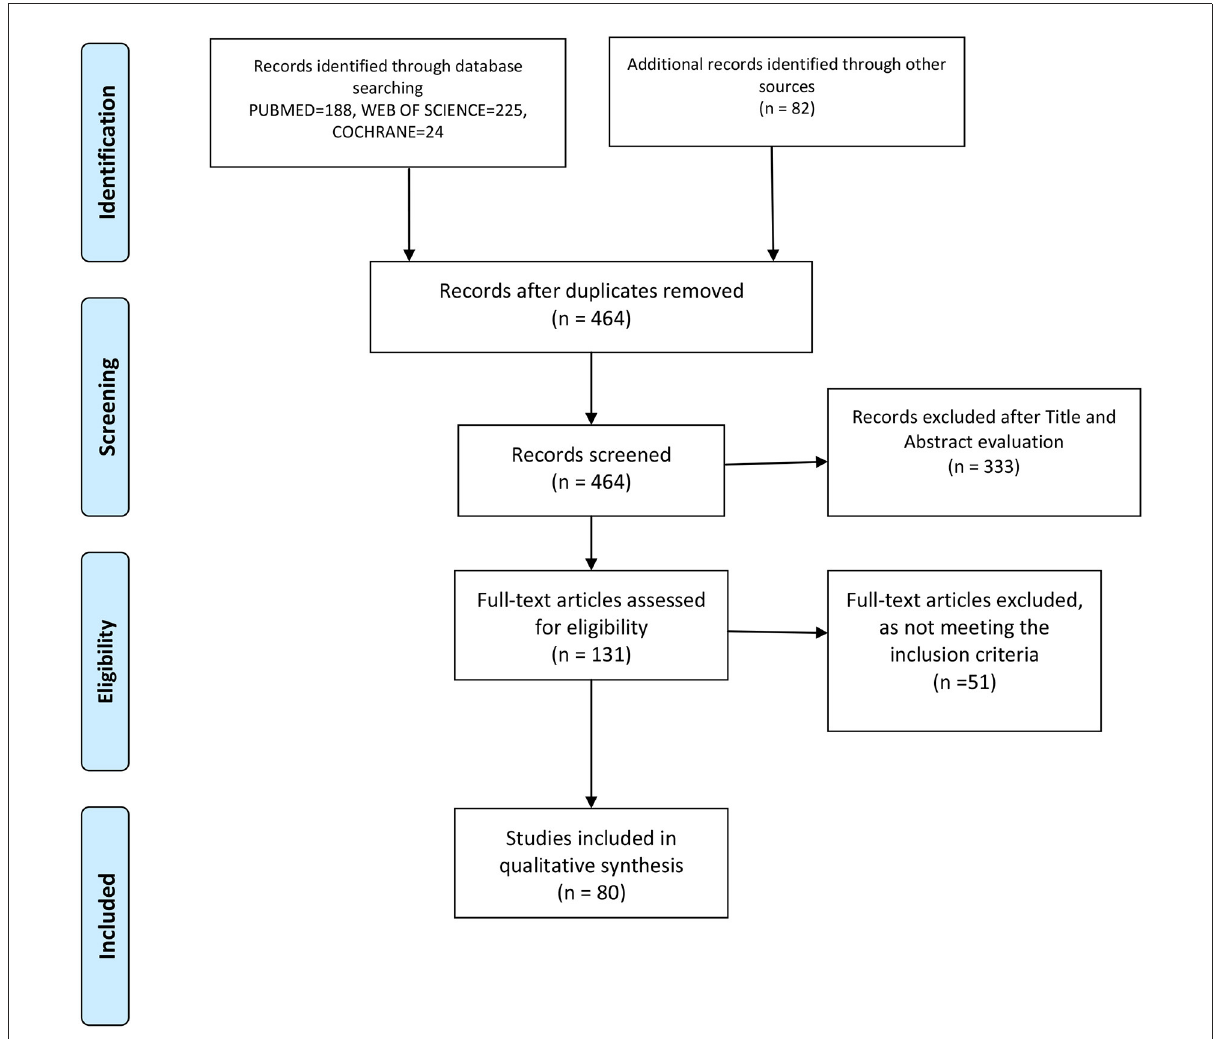
FIGURE1 PRISMA flowchart of the included